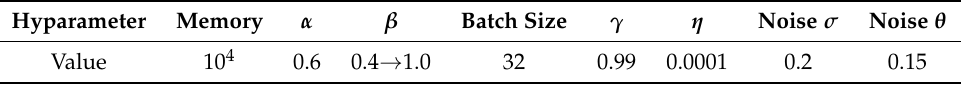
Table 2. The main hyperparameters for every baseline. There are some other hyperparameters that are the same as DDPG + PER [12]. All tasks use the same hyperparameter